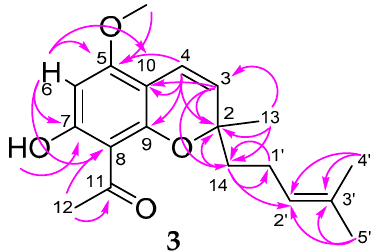
Molecules 2021 , 26 , 688 Figure 3. Key correlations of 3 in the HMBC spectrum. Figure 3. Key correlations of 3 in the HMBC spectrum.